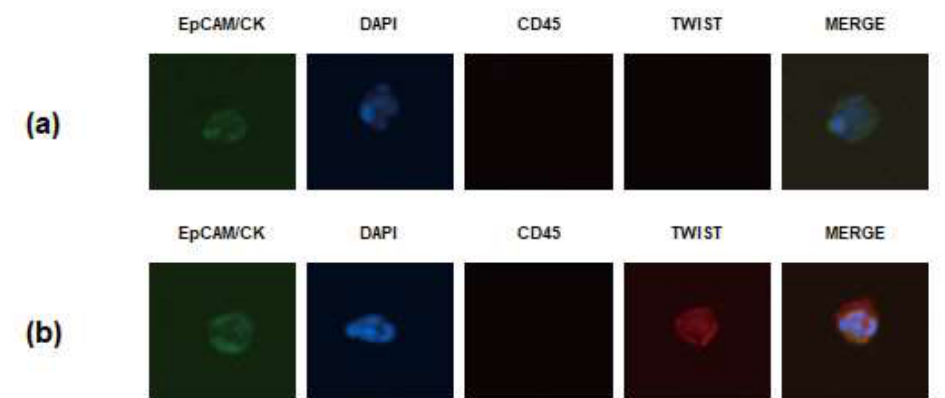
Figure 2. Circulating tumor cells (CTCs) detected in patients with metastatic gastric cancer. ( a ) Rep- resentative images of CTCs negative for TWIST immunostaining. ( b ) Representative images of CTCs positive for TWIST immunostaining.